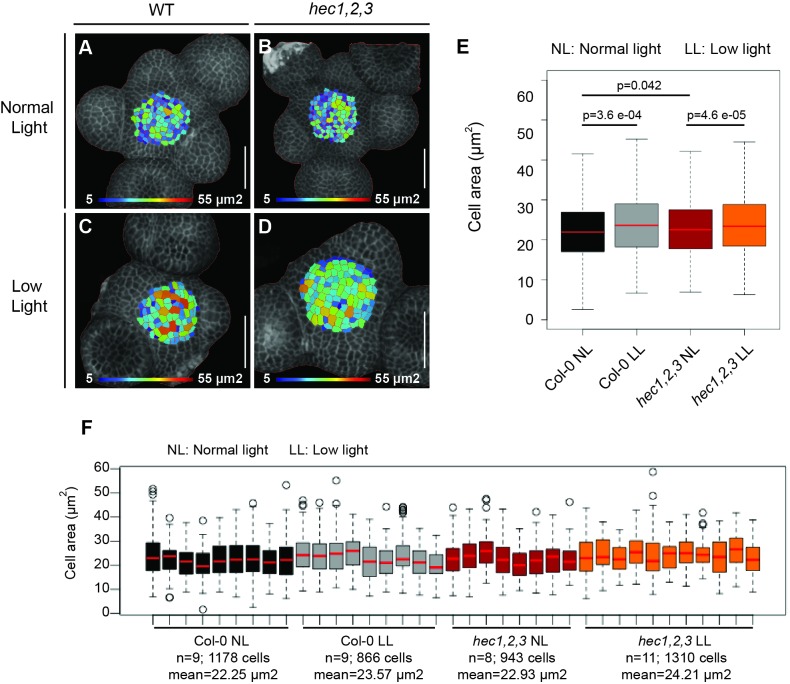
Cell size at the SAM after transfer to low light conditions.(A–D) Cell area representation of wild type (A, C) and hec1,2,3 (B, D) plants grown under normal (A, B) and low light intensity conditions (B, D). Heat map colors depict cell size (µm2). (E–F) Cell area quantification in wild type and hec1,2,3 grown under different light regimes (E). Cell area distribution in individual shoot meristem analysed (F). NL: Normal light intensity (200 µmol m−2 s−1), LL: Low light intensity (15 µmol m−2 s−1). Statistical test: Wilcoxon signed-ranked test (E). Scale bar: 50 µm.